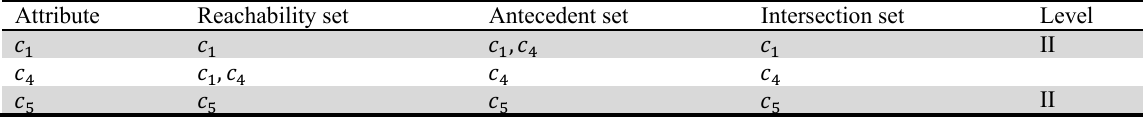
Second iteration of partition analysis